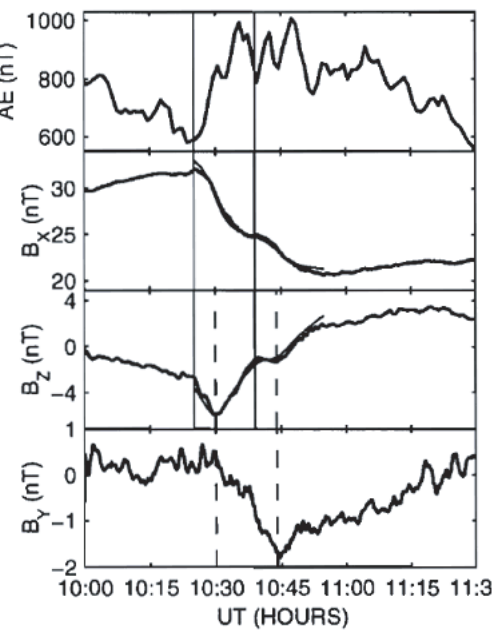
Fig. 14. Cross-tail current disruption effects measured in the lobe, onboard ISEE-1 at X =− 20 R E . The AE index is shown at the top. The three bottom panels display the variations of the components of the lobe magnetic field. (From Jacquey et al.,